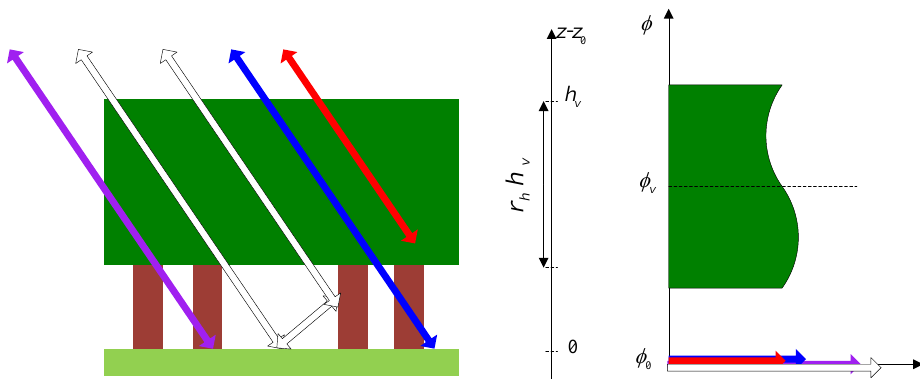
Figure 3. Two-layer coherence RVoG model illustration for vegetated land surface. The different colors of the arrow on the left represent different scattering mechanisms and the corresponding phases are shown on the right side. The surface, double-bounce, and short understory cause similar interferometric phases at the ground level. The volume layer introduces a phase offset and an additional decorrelation due to phase variation.